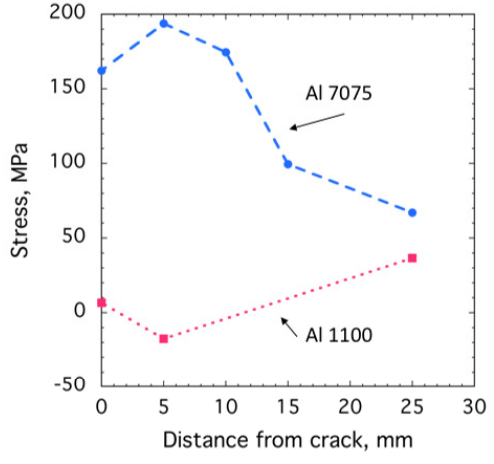
Figure 11. The estimated residual stress as a function of position from